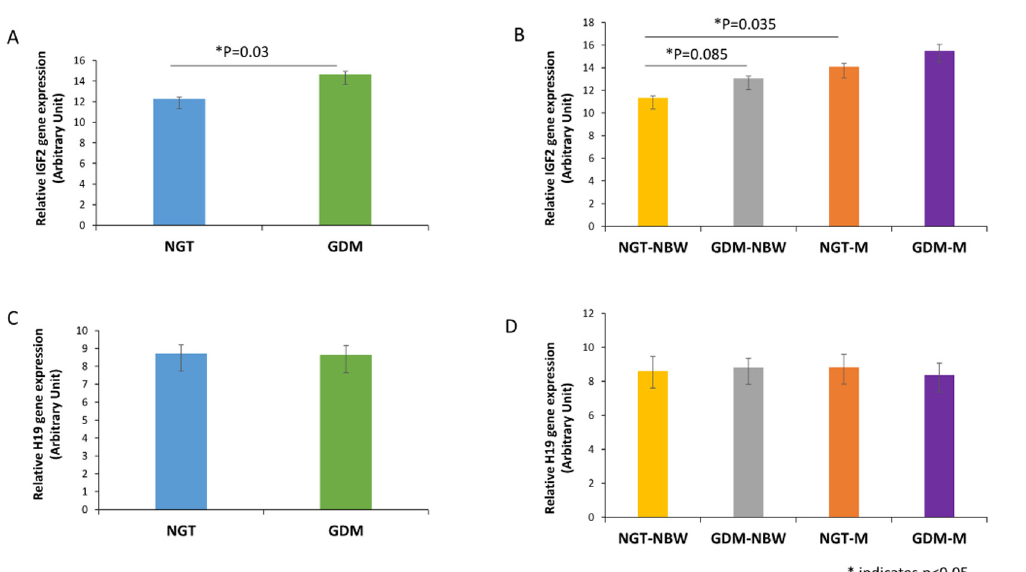
Fig 1. IGF2/H19 Expression in Placenta. (A)The expression of IGF2 in placenta was significantly higher in GDM group than that in NGT group. (B) The expression of IGF2 in placenta was significant higher in NGT-M group than NGT-NBW group. (C)The expression of H19 in placenta from GDM group had a trend to be decreased compared with control group. (D) There is no significant difference in placenta in each group. * indicates p <